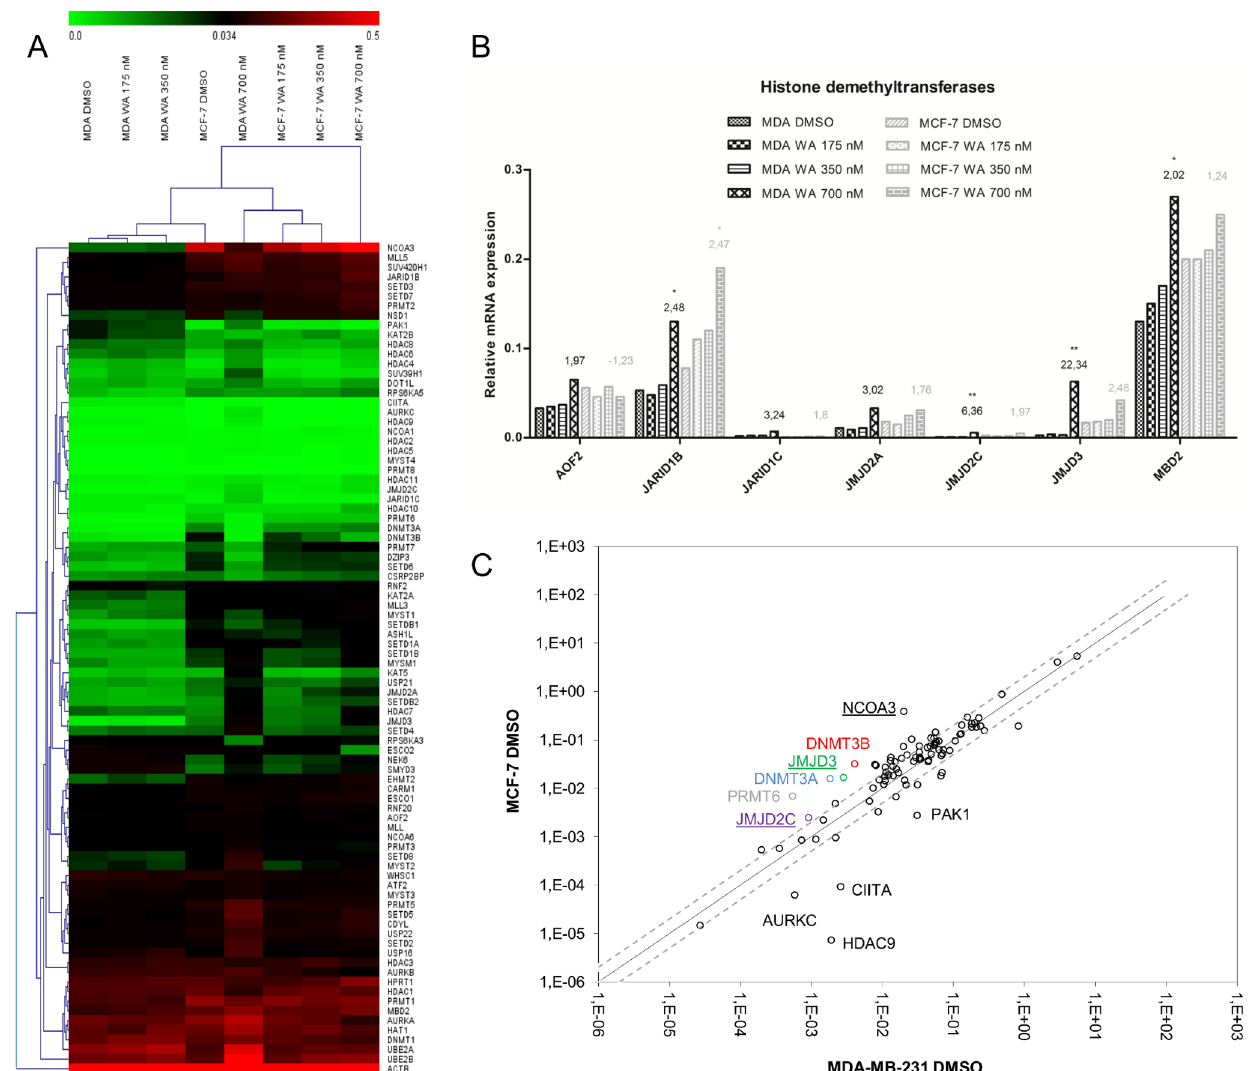
Figure 6. Modulation of chromatin writer-reader-eraser enzymes by WA in MDA-MB-231 and MCF-7 cells. (A) The heatmap represents gene expressions of 84 known or predicted genes coding for chromatin-modifying enzymes and two housekeeping genes ( ACTB, HPRT ) for control and WA-treated MDA-MB-231 and MCF-7 cells. Mean 2 2 D Ct values are compared pair-wise to MDA-MB-231 solvent control sample. The data represent values from at least two independent experiments. Color key legend above the heatmap represents 2 2 D Ct normalized expression values ranging from green (low expression) to red (high expression). (B) Bar graphs representing mean 2 2 D Ct normalized expression values of genes encoding for histone demethyltransferases from at least two independent experiments. Fold changes between control (DMSO) and 700 nM WA-treated samples are indicated above the corresponding bars. Significantly upregulated genes are marked with asterisks. (C) The scatter plot of the mean 2 2 D Ct normalized expression values of each gene in the control sample (MDA-MB-231 DMSO) versus the test sample (MCF-7 DMSO). The most differentially expressed genes are labeled next to the corresponding dot. WA-regulated genes are underlined. The black line indicates fold change 2 2 DD Ct of 1. The dashed, gray lines indicate desired fold-change in gene expression threshold, here defined as 2.